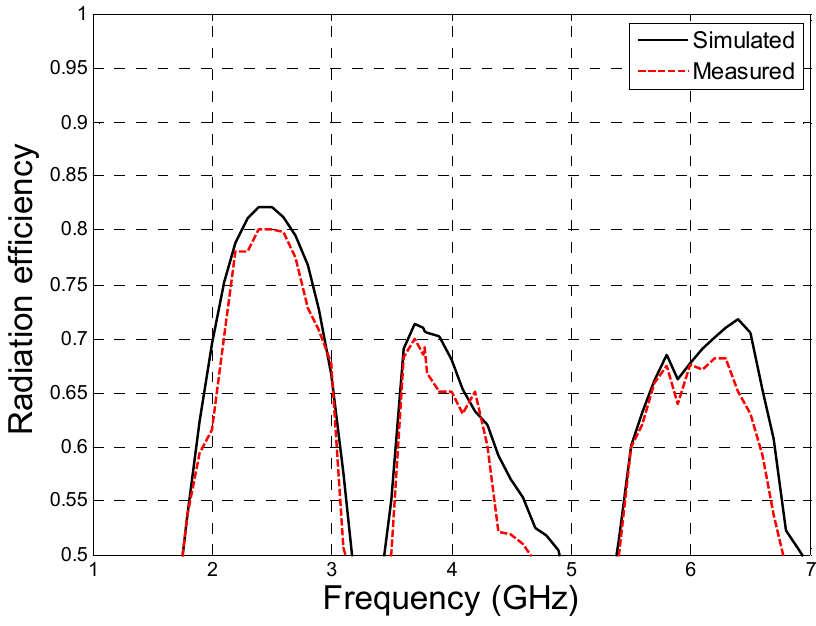
Figure 15. The radiation efficiency of the antenna as a function of frequency. It is important to notify that the miniaturization of the antenna size should not result in deep reduction in the value of the antenna gain and bandwidth or the covering area of the radiation pattern. For example, the antenna in [29] has a very compact size (20 × 18 mm 2 ) with dimensions fabricated on an RT Duroid 6006 substrate with dielectric constant of 6.15 and 2.54 mm in height. The bands covered are 3.2 GHz, 4 GHz, and 5.9 GHz with fractional bandwidth of 3.12%, 2.5%, and 2.54%, respectively, and the gain was not reported. In study [30], the antenna has a compact size of (24 × 22 mm 2 ), but did not have an omnidirectional radiation pattern which is most appropriate for IoT application. In addition, the antenna in [31] is a UWB antenna with dimensions equal to (15 × 17 mm 2 ) but